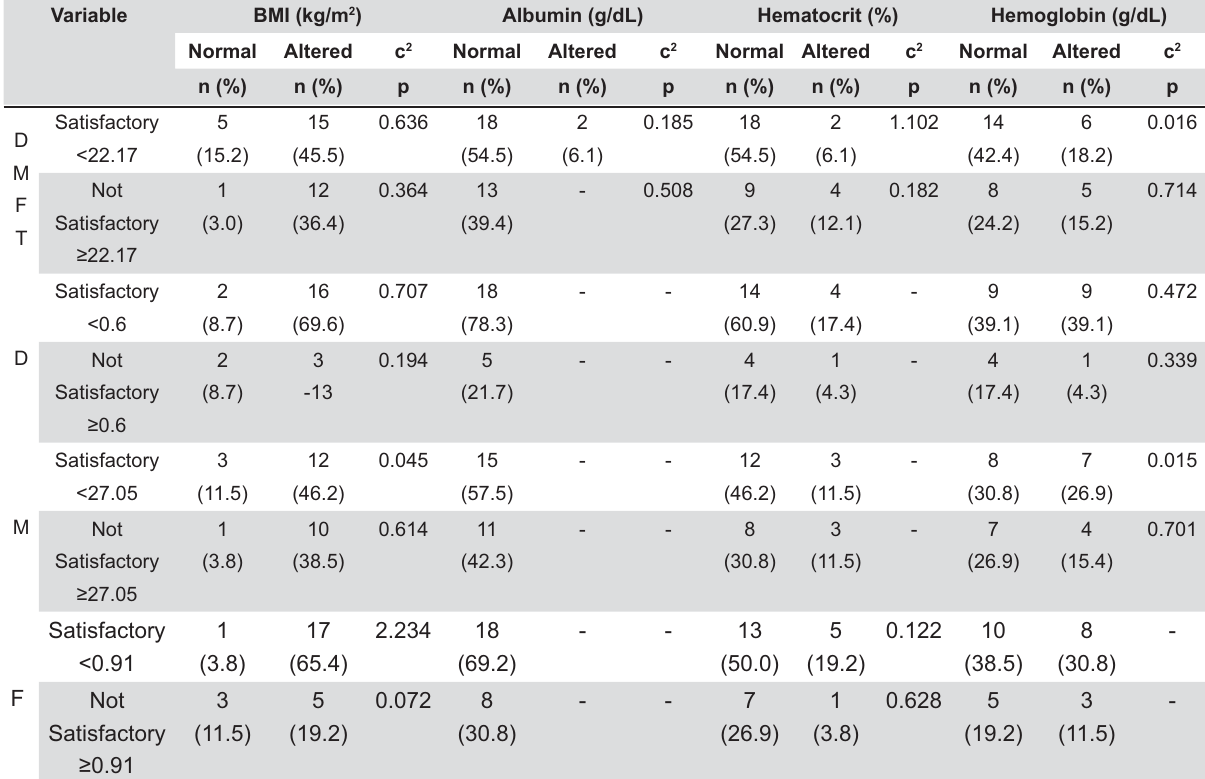
Table 3- Association between Body Mass Index (BMI), albumin, hematocrit, hemoglobin and decayed (D), missing (M) and